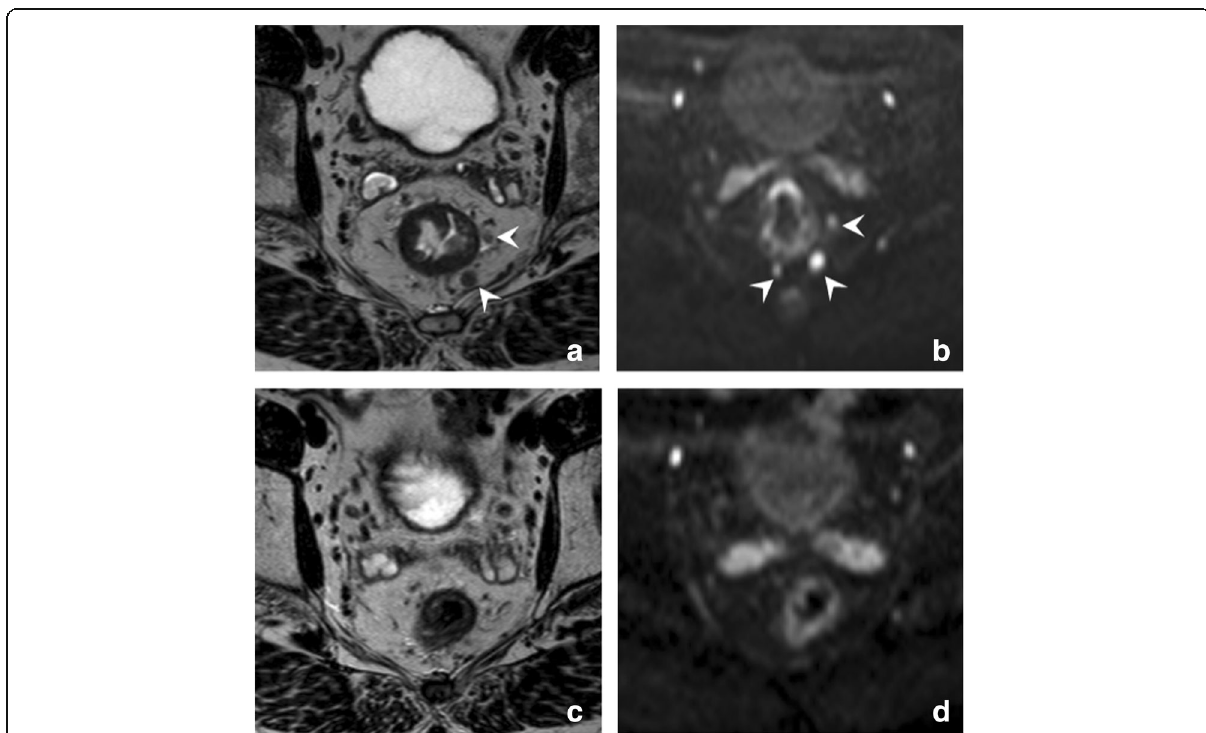
Fig. 11 DWI for assessment of lymph nodes. Pre-CRT T2-weighted ( a ), b1000 DWI ( b ), and corresponding post-CRT T2-weighted ( c ) and b1000 DWI ( d ) images of a male patient with a low rectal tumor. On the pre-CRT images, several lymph nodes are visible (arrowheads). Note that the nodes are much easier detectable on DWI and that more nodes can be appreciated on DWI compared to T2-weighted MRI. After CRT, all the lymph nodes have vanished, both on T2W as well as on DWI. The absence of nodes on DWI is a reliable sign indicating a ypN0 stage (which was later confirmed at histopathology after surgery in this